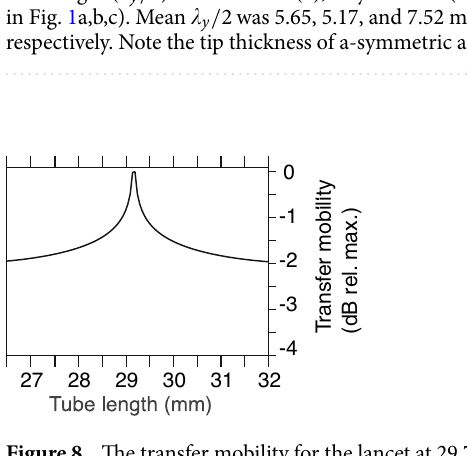
Measured deflection. The following refers to Fig. 12 and Table 2. The lancet (L) deflected the most (with high significance to all tips, p < 0.017) in both air and water (Fig. 12a), achieving the highest DPR (up to 220 µm/W in air). In air, AX1 which had higher BL, deflected higher than AX2–3 (with significance, p < 0.017), while AX3 (which had lowest BL) deflected more than AX2 with a DPR of 190 µm/W. In water at 20 mm, no significant differences ( p > 0.017) were found in deflection and PTE for AX1–3. PTE levels were overall higher